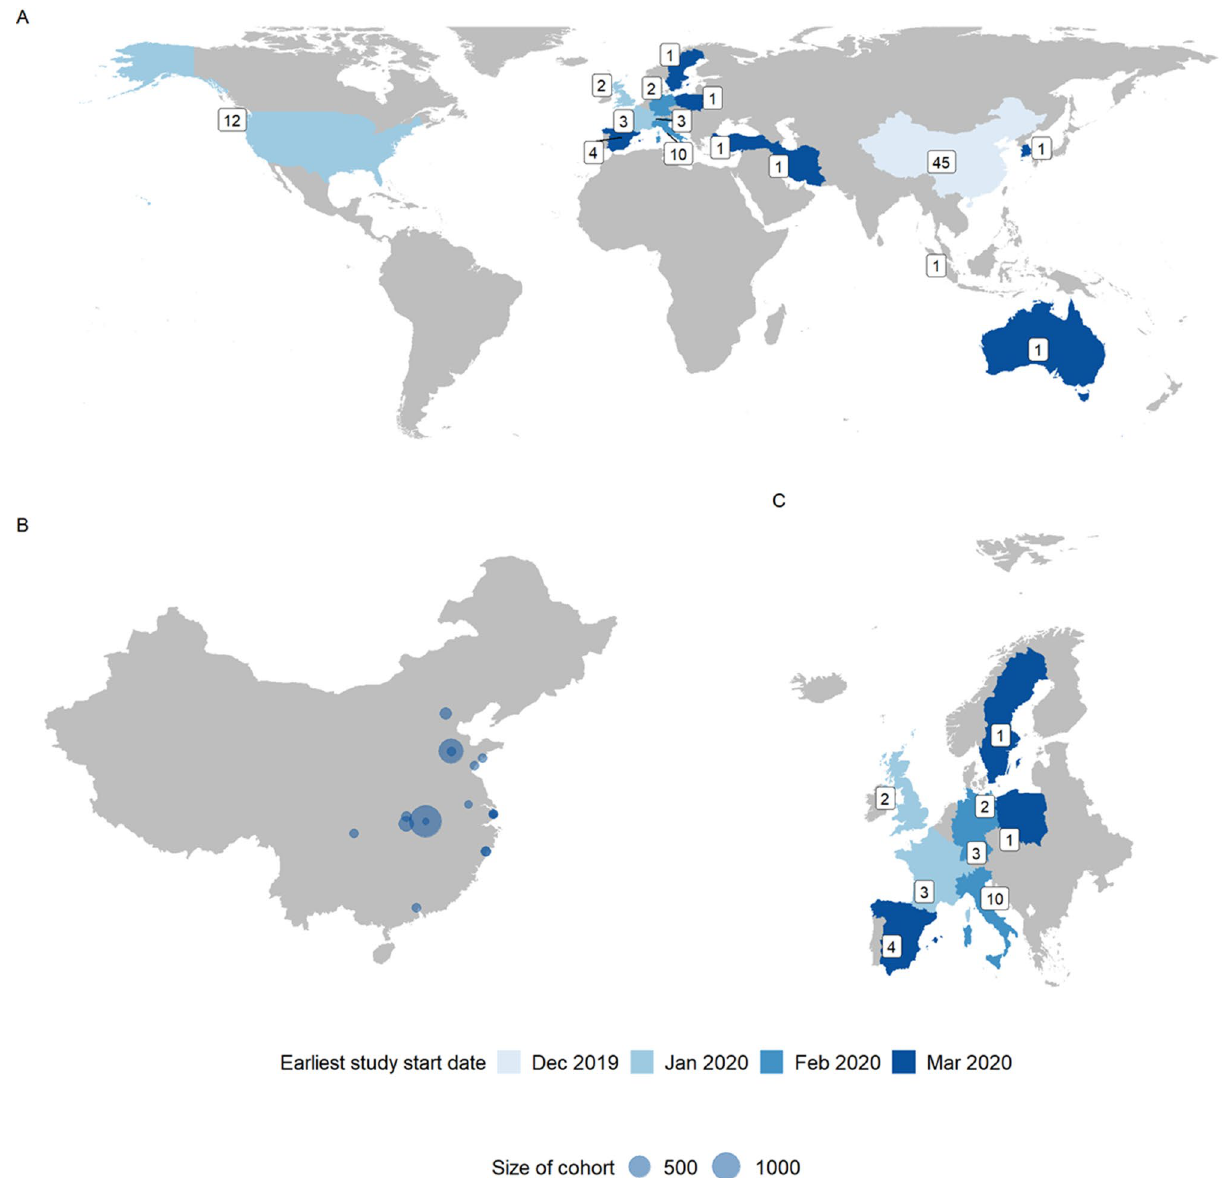
Figure 2. Distribution of studies over geography and time. ( A ) The distribution of studies globally where the label denotes number of studies in a country and colour denotes earliest recorded study start date. ( B ) Study locations in China where dot size corresponds to number of participants in entire study. ( C ) The distribution of studies in a subset of European countries where the label denotes number of studies in a country and colour denotes earliest recorded study start date. Studies including individuals from multiple countries, or without a city in China, were omitted from the map, n =